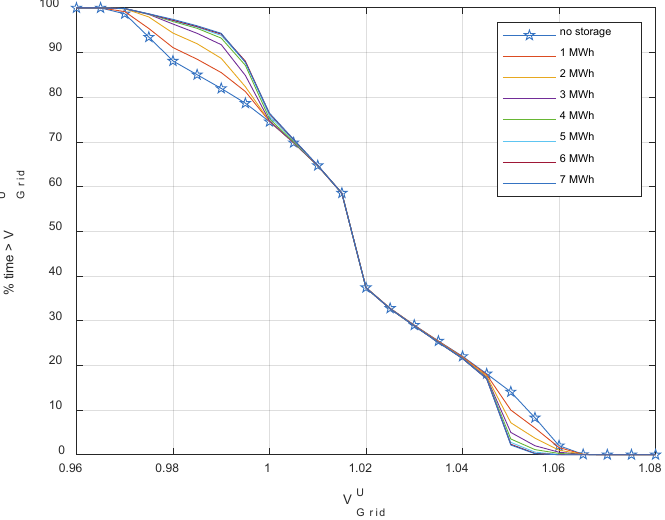
Fig. 4. Percentage of time when the grid voltage is above a certain level for different BESS sizes. Another simulation over the full month of June shows that the alternative strategy of active power curtailment obtaining the same results for the grid voltage as the BESS would have wasted about 138 MWh of energy. Comparing this value to the average household consumption of electrical energy mentioned in chapter 3, the energy amount of nearly 100 households over the entire summer half would have been curtailed. In this setting a battery with 28 MWh of capacity would have been necessary to guarantee the absorption of active power during times of overproduction. Fig. 7 depicts the potential for improvement in terms of battery size reduction, if it were specified in the algorithm that the SOC at the end of a day should always be the same as that at the beginning of the simulation. It can be assumed that this would result in the required capacity being a fraction of the 28 MWh